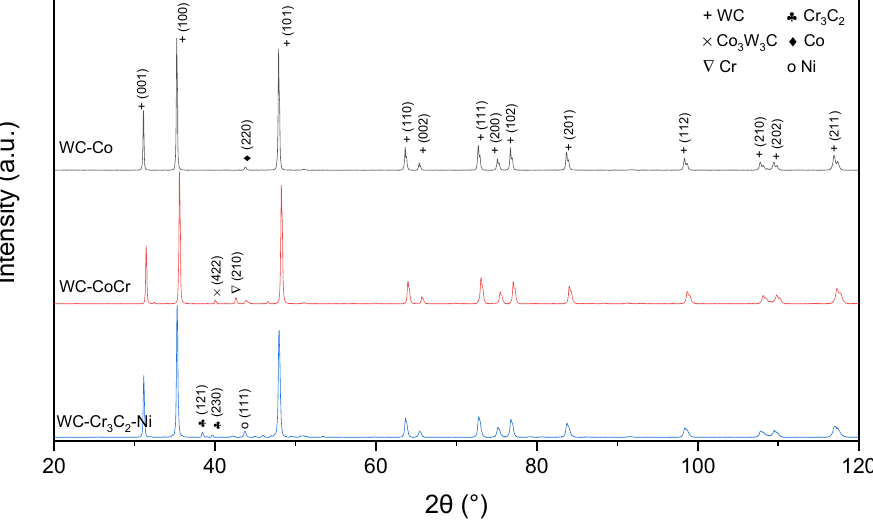
Figure 14. XRD patterns of feedstock powders.